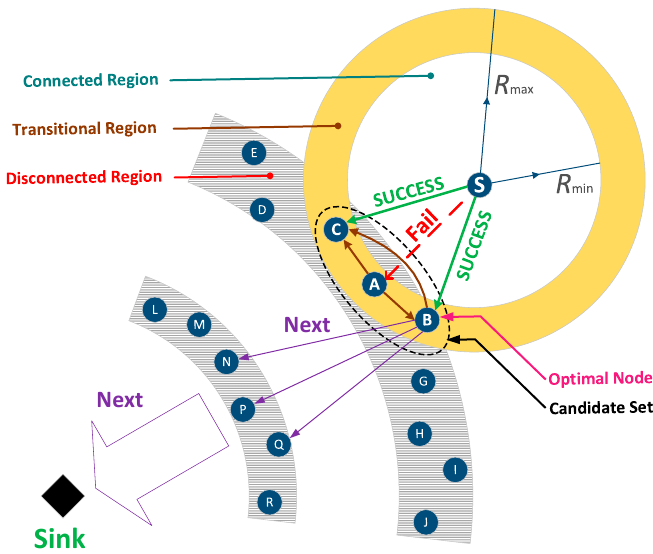
Figure 1. Illustration of opportunistic routing scheme.